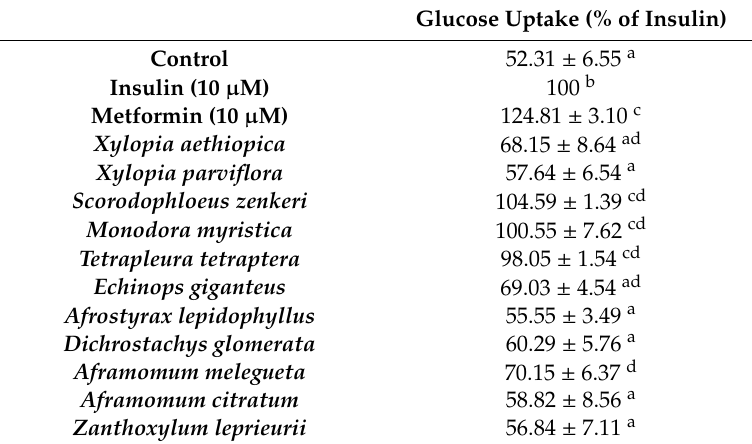
Table 3. Glucose uptake in HepG2 cells: e ff ect of spice extracts.